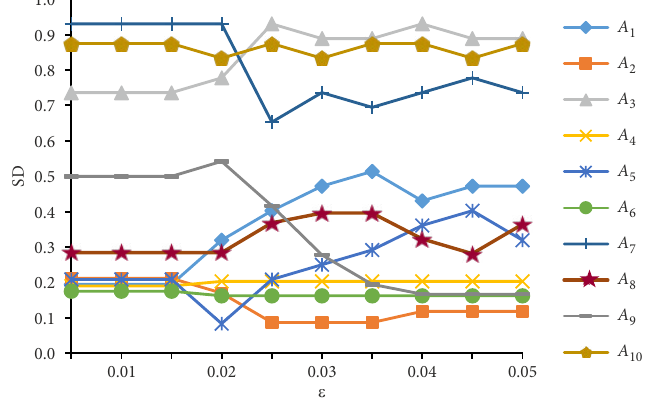
Figure 5. Impact of e on the support degree of